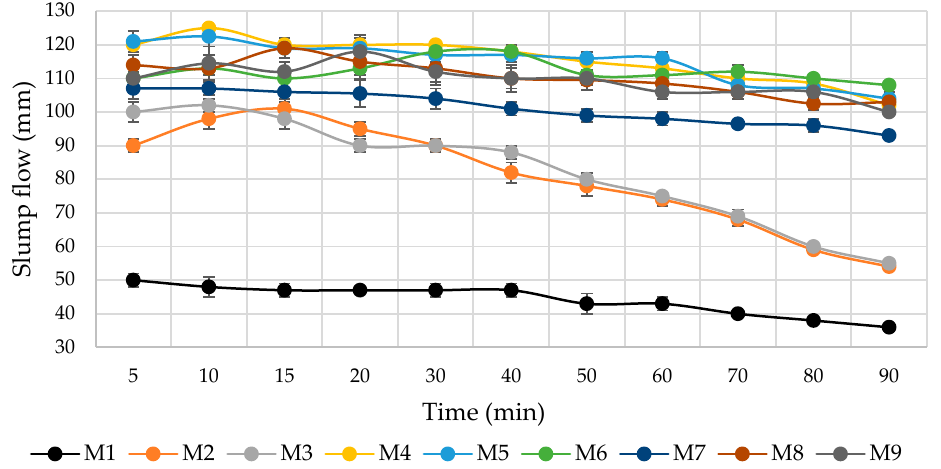
Figure 3. Slump flows of cement Figure 3. Slump fl ows of cement mortars.